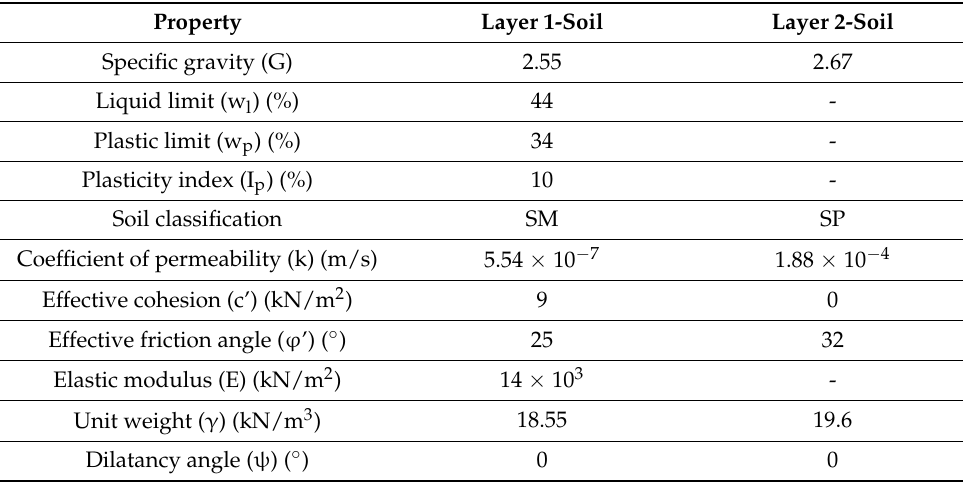
Table 1. Properties of